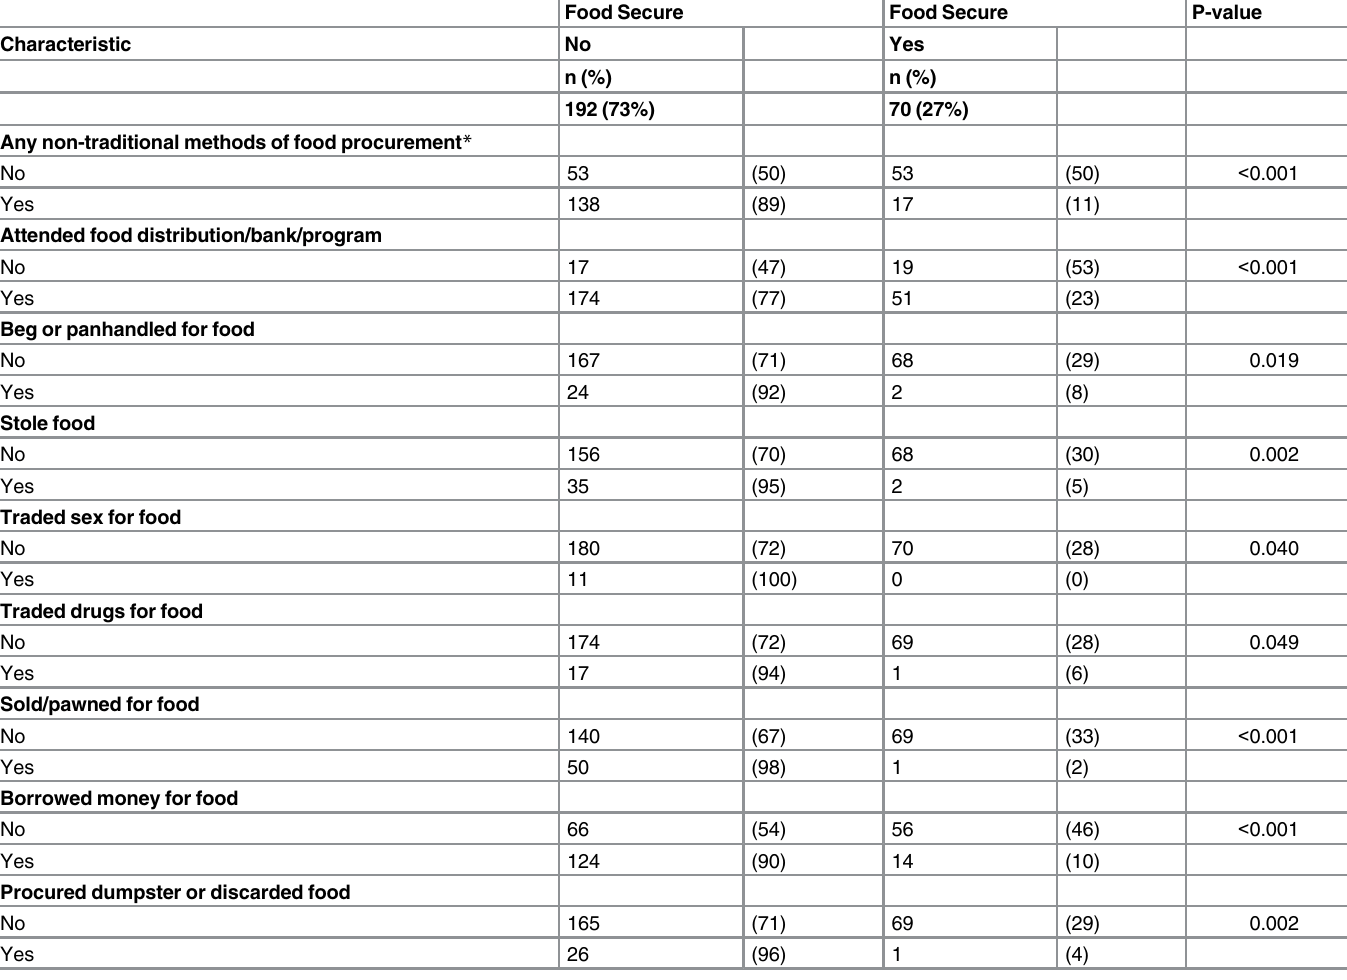
Table 6. Bivariate comparison of procurement methods by food security status (n =